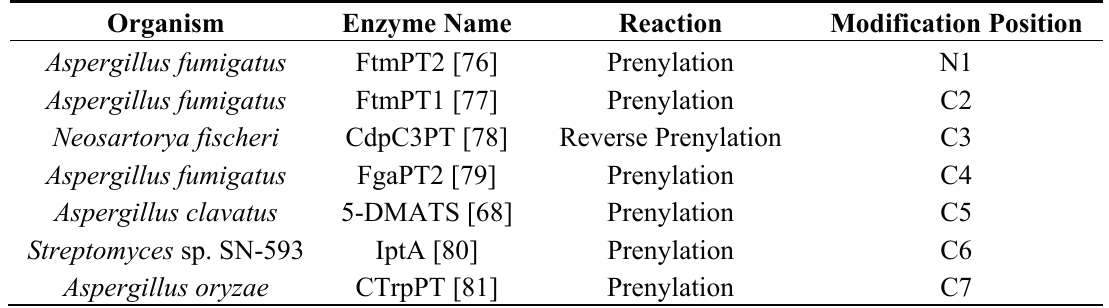
Table 2. Overview of different prenyltransferases able to modify all viable positions in the indole side chain of tryptophan